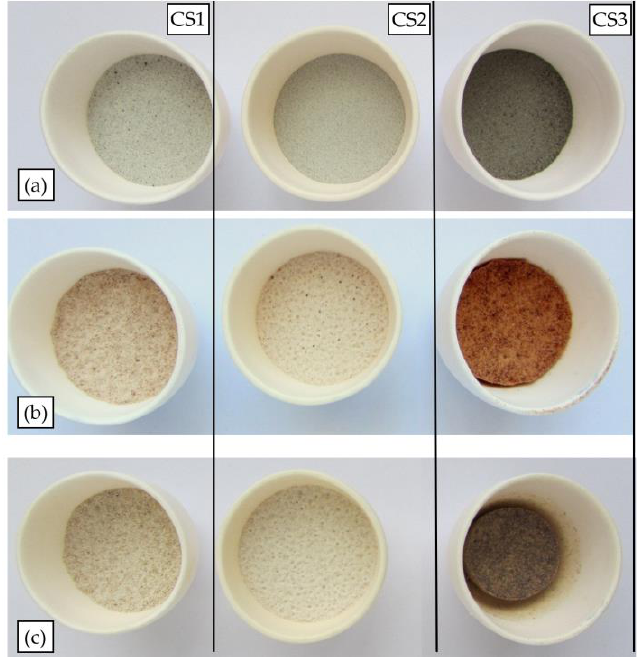
Figure 10. Images of cenospheres at various stages of heat treatment: ( a ) as-received, ( b ) 1100 °C and ( c ) 1200 °C. ( c ) 1200 ◦